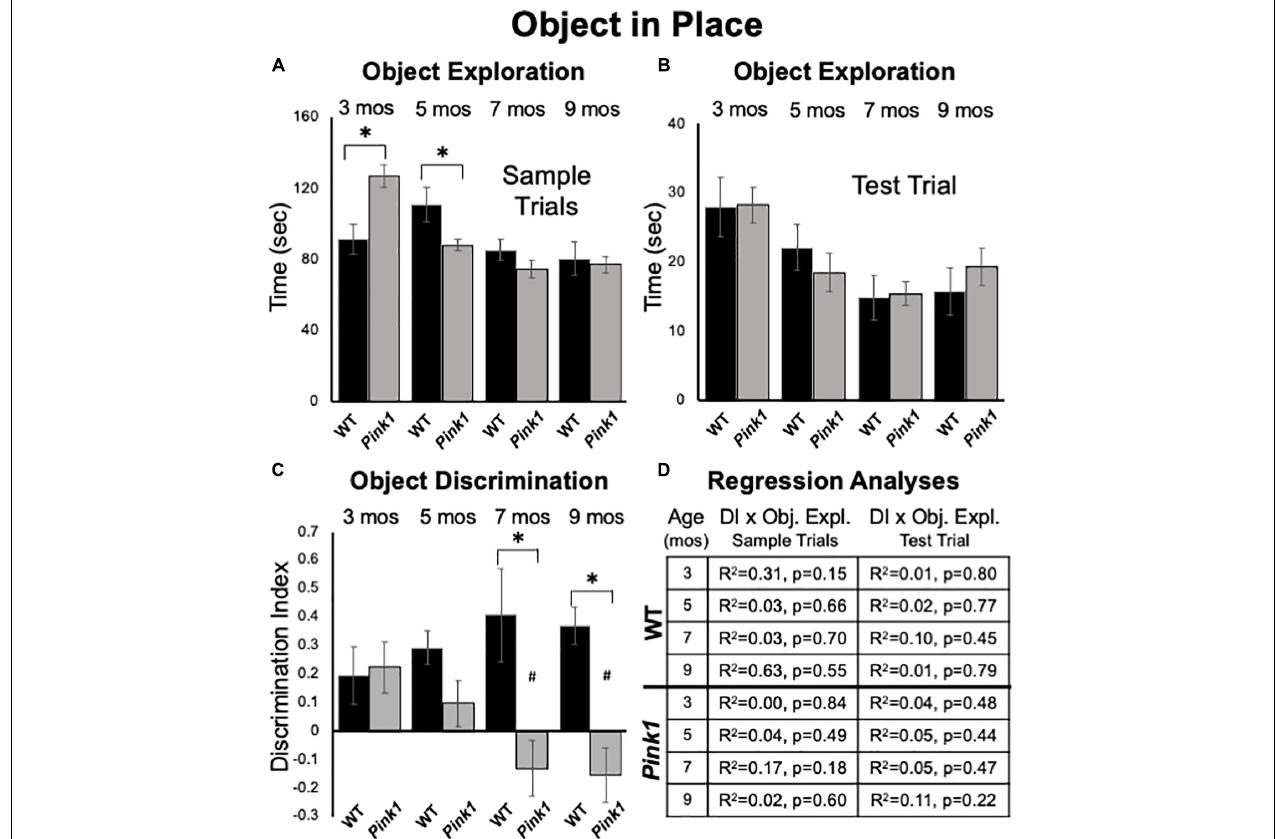
FIGURE 7 | Object-in-Place data. Bar graphs showing total times in seconds (sec) that wild type (WT, black bars) and rats with knockout of the PTEN (phosphatase and tensin homolog)-induced putative kinase1 gene ( Pink1–/–, gray bars) spent actively exploring objects during Sample Trials (A) and during Test Trials (B) in testing at 3, 5, 7, and 9 months (mos) of age. In general, the amounts of time spent exploring objects were comparable among the Pink1 –/– WT groups. However, asterisks in (A) identify object exploration times that were significantly greater in the Pink1 –/– compared to WT cohort for testing at 3 mos of age, and that were significantly greater in the WT compared to Pink1 –/– rats for testing at 5 mos of age during. (C) Bar graphs showing calculated discrimination index (DI) for WT (black bars) and Pink1 –/– rats (gray bars). This measure of integrated object recognition memory was similar in rats of both genotypes at 3 and 5 months of age. At all other ages, DIs were significantly greater ( ∗ ) in WT than in Pink1 –/– rats. Within groups comparisons of DI across age showed that in Pink1 –/– rats, DIs measured at 7 and 9 months of age were significantly lower (#) then DI measured at 3 and 5 months of age. (D) Tables showing R 2 and p -values for regression analyses comparing DIs to total sample object exploration times and to test trial object exploration times in wild type and Pink1 –/– rats at each age tested. No significant or near significant correlations were found among these measures.